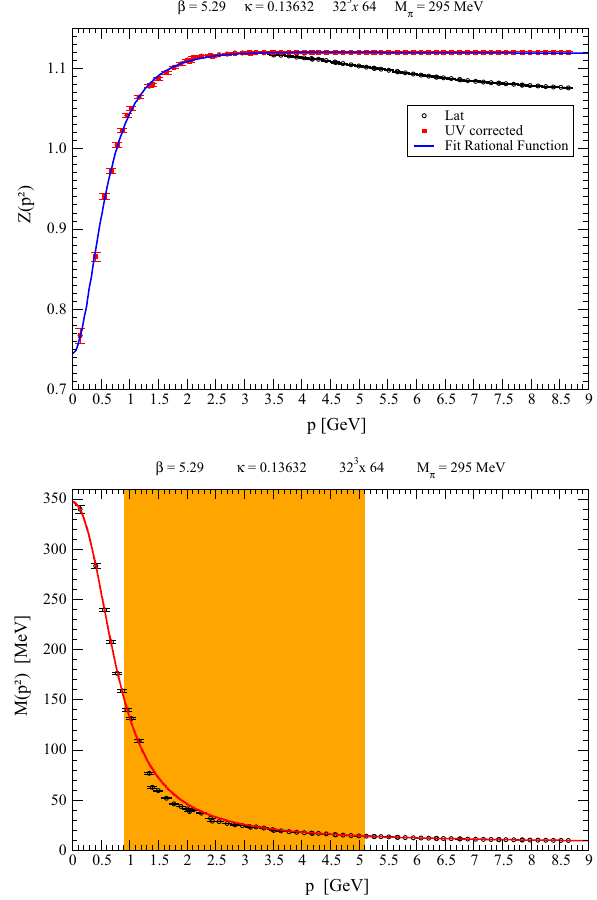
Fig. 5 Quark wave function (top) and running mass (bottom) lattice functions from full QCD simulations with N f = 2